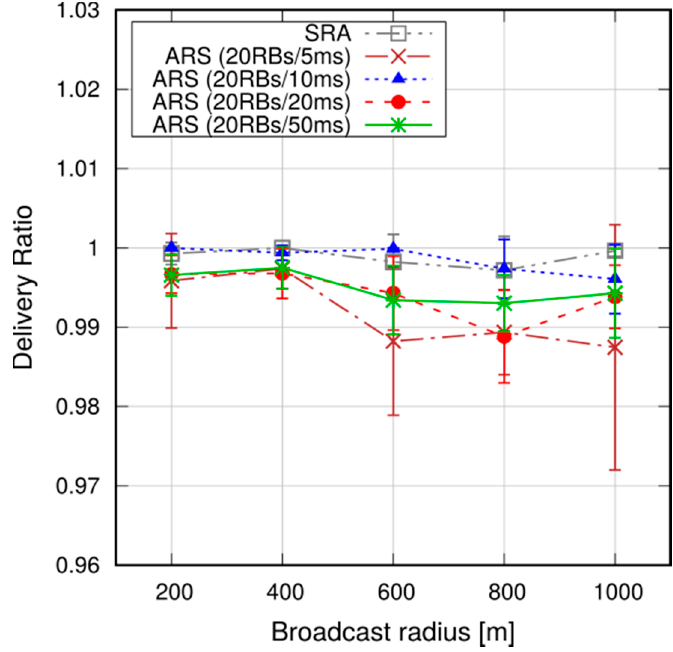
Figure 19. SRA vs. ARS, delivery ratio.